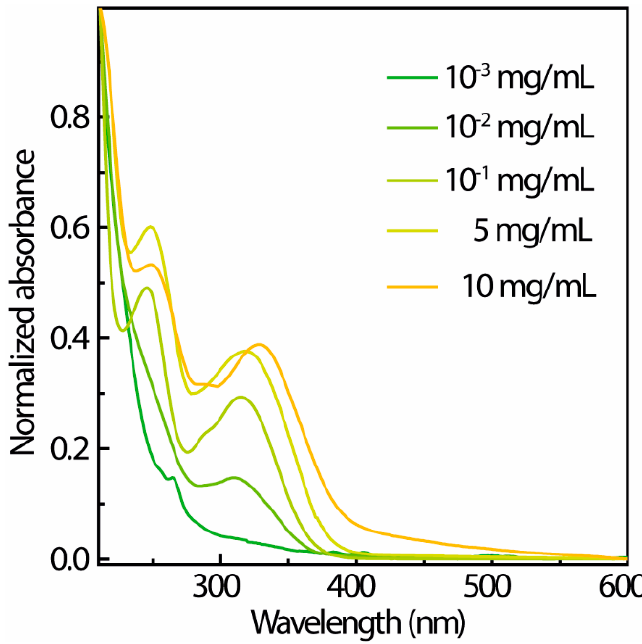
Figure 5. UV–Vis spectra of S-TPE-1 doped with varying concentrations.